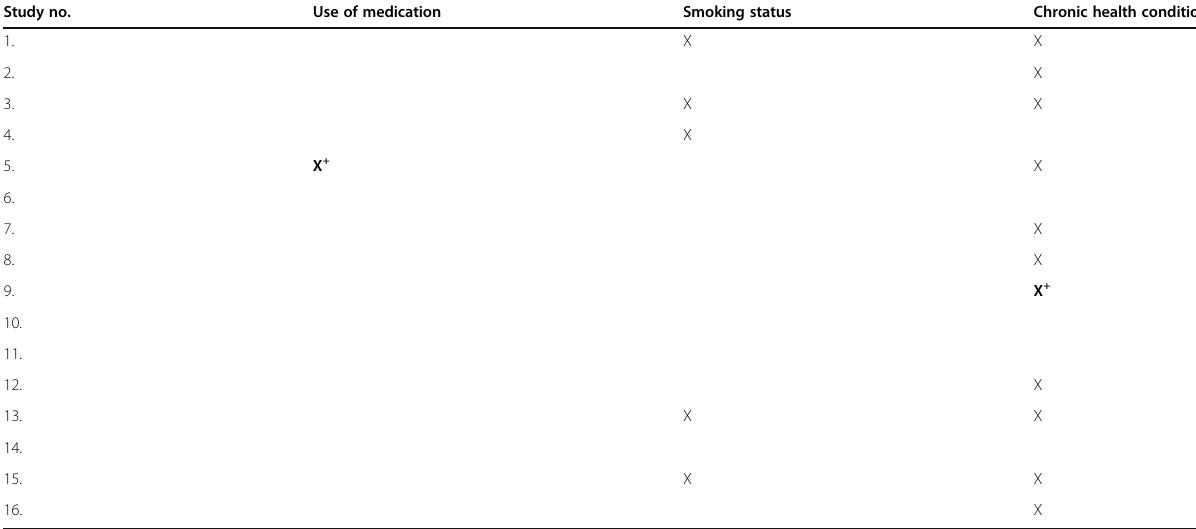
Table 7 Reported risk factors Study